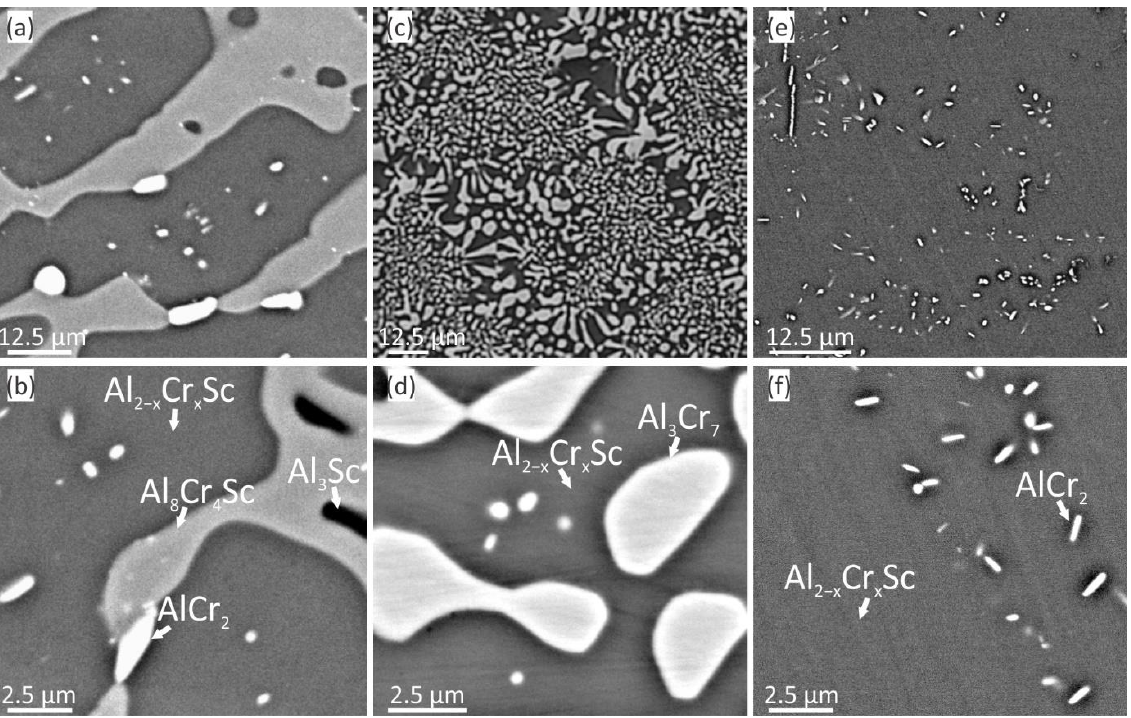
Figure 3. SEM/BSE images at two different magnifications of cross-sectioned samples after being annealed at 990 °C for 240 h: ( a , b ) sample I with composition Al 58.2 Cr 19.4 Sc 22.4 ; ( c , d ) sample II, Al 42.70 Cr 38.60 Sc 18.7 ; ( e , f ) sample III, Al 52 Cr 14 Sc 34 . The arrows in the higher-magnification micrographs denote different phases.